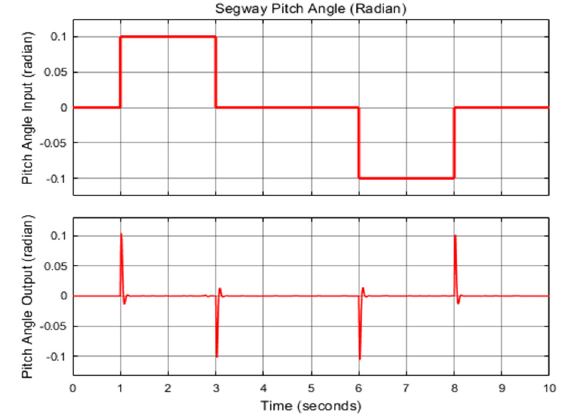
Fig. 9: Segway Pitch Angle Response for 0.1 Radian Change